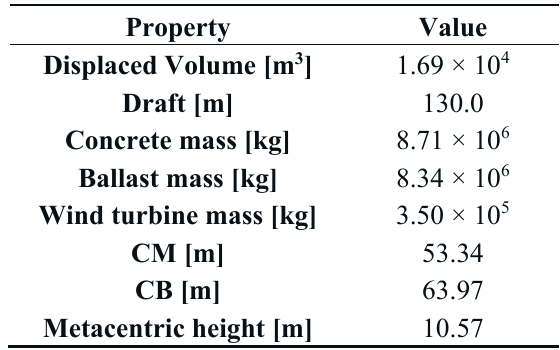
Table 1. Hydrostatic characteristics of Windcrete.